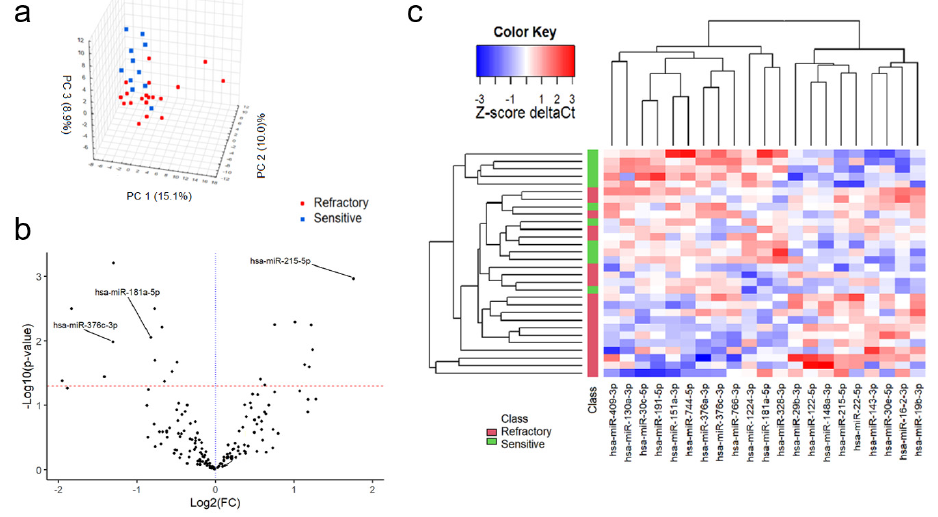
Figure 1. Comparision of miRNA expression between MM patients sensitive and refractory to bortezomib-based treatment. 3D plot of principal comptonent analysis (PCA) score performed on all 155 miRNAs ( a ). Volcano plot of filtered miRNAs. miRNAs included in the logistic regression model are indicated by their labels ( b ). Heatmap of significantly differently expressed miRNAs between study subgroups ( c ). Table 2. List of miRNAs with significantly different expression between groups in univariate analysis.